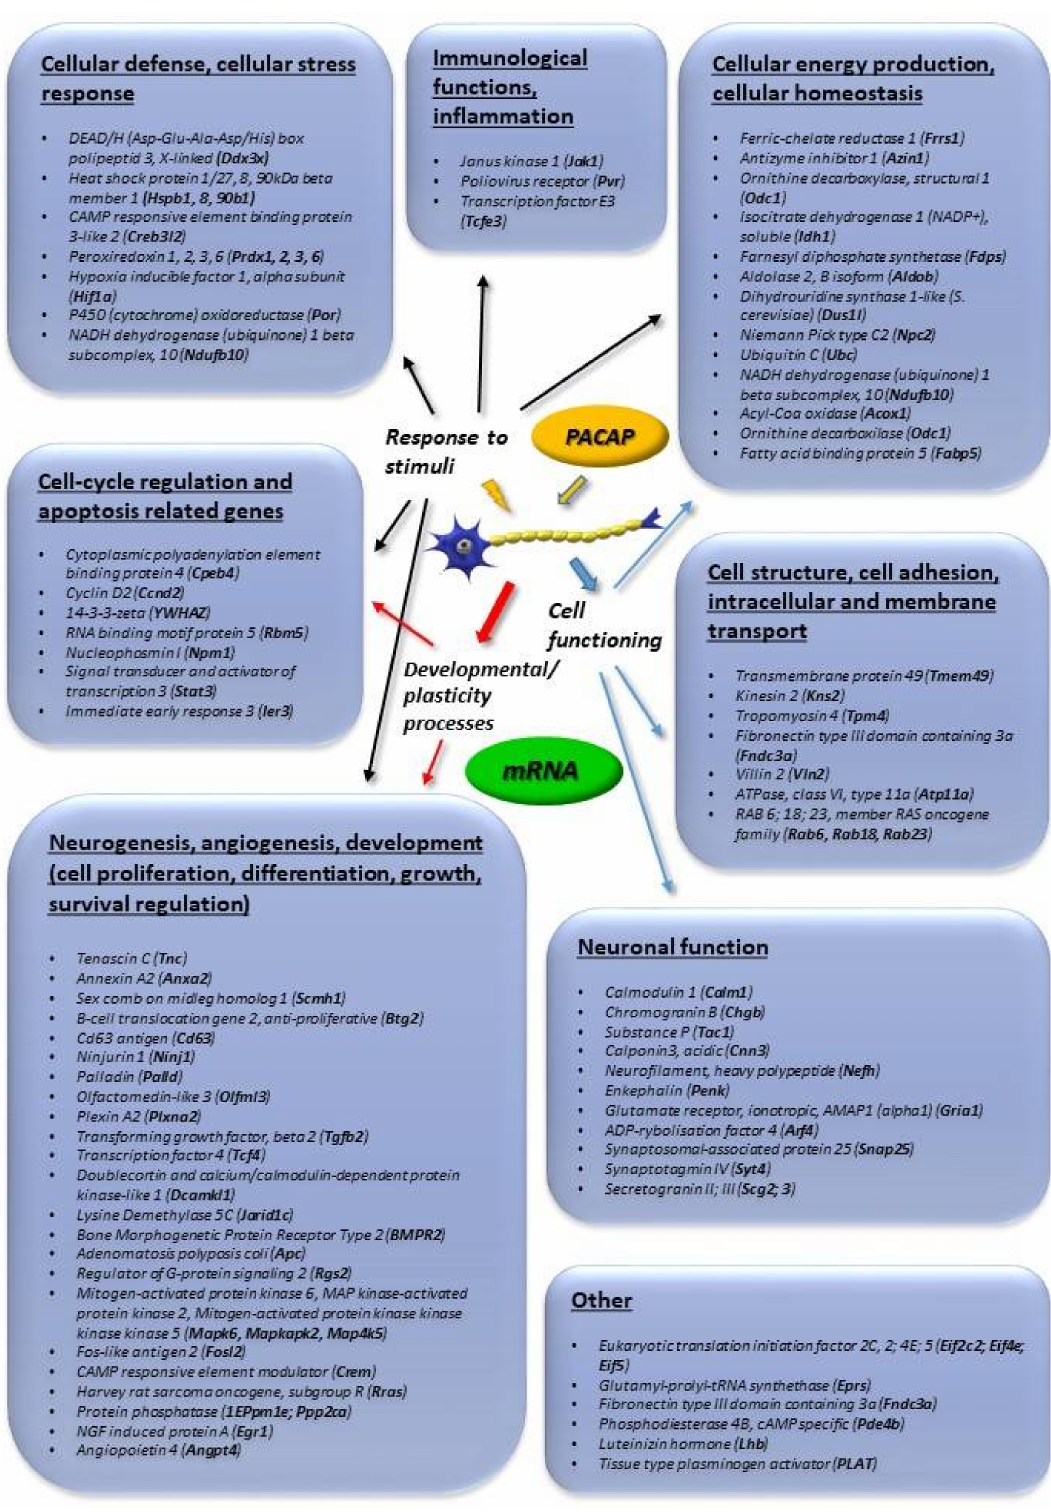
Figure 1. Main in vitro transcriptomic changes induced by pituitary adenylate cyclase activating polypeptide (PACAP). Genes upregulated more than 2-fold are listed. The data in the figure come from the references: